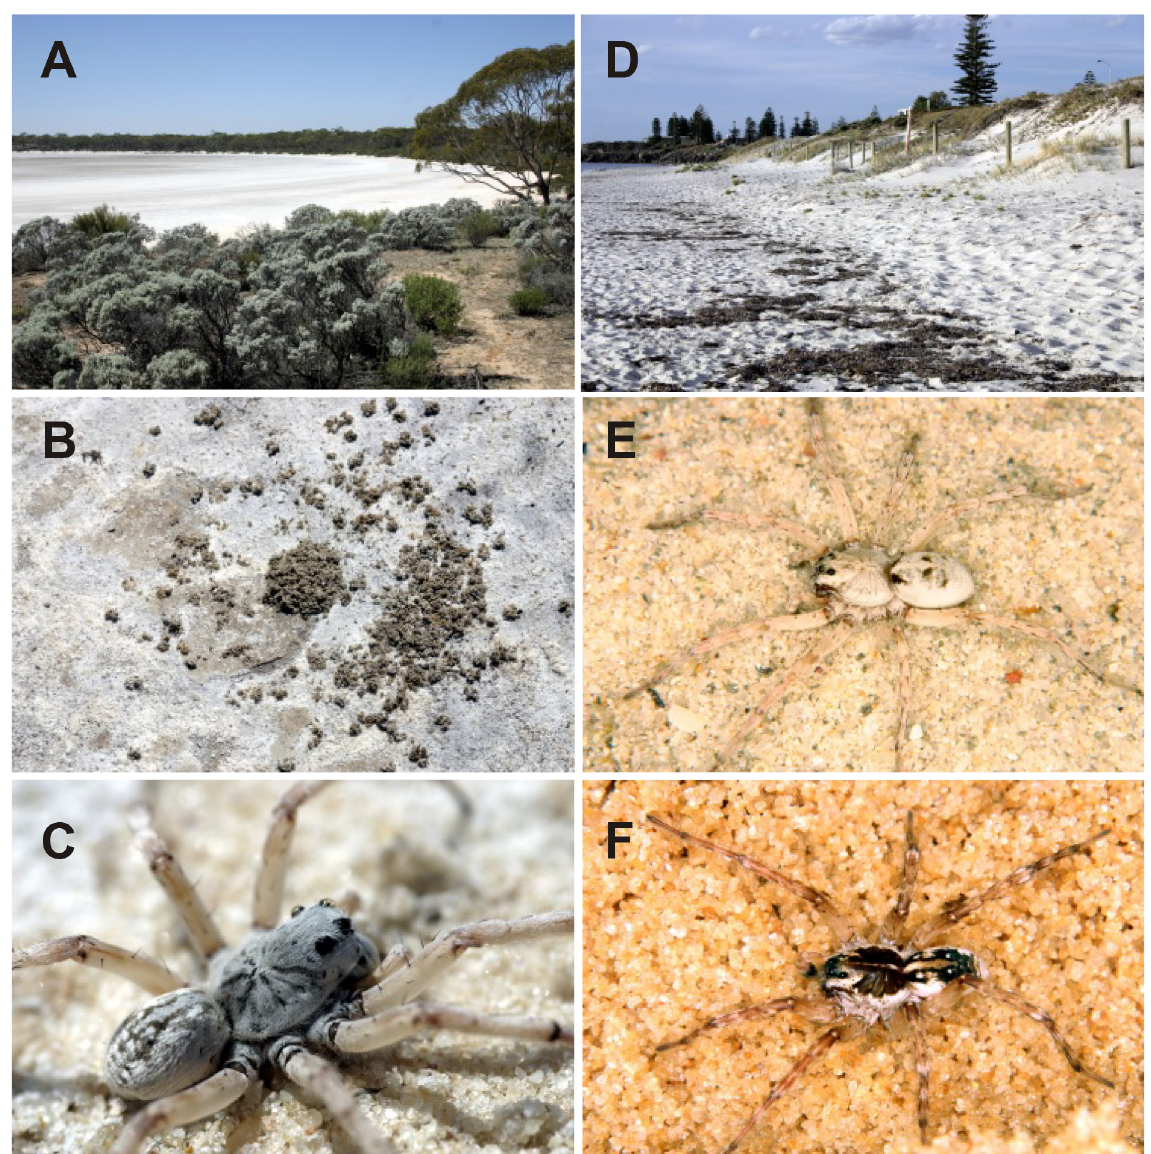
Fig. 1. Typical habitats and live images of Tetralycosa Roewer, 1960. A . Salt lake (southern Lake Lefroy, Western Australia), where T. alteripa (McKay, 1976) and T. baudinettei sp. nov. can be found. B . T. alteripa (McKay, 1976), burrow on Lake Lefroy. C . T. alteripa (McKay, 1976), ♀ from Lake Lefroy. D . Sea shore (Cottesloe Beach, Western Australia), where T. oraria (L. Koch, 1876) can be found. E . T. oraria (L. Koch, 1876), ♂ from Cottesloe Beach (WAM T65606). F . T. oraria (L. Koch, 1876), ♂ from Safety Beach (Western Australia) (WAM